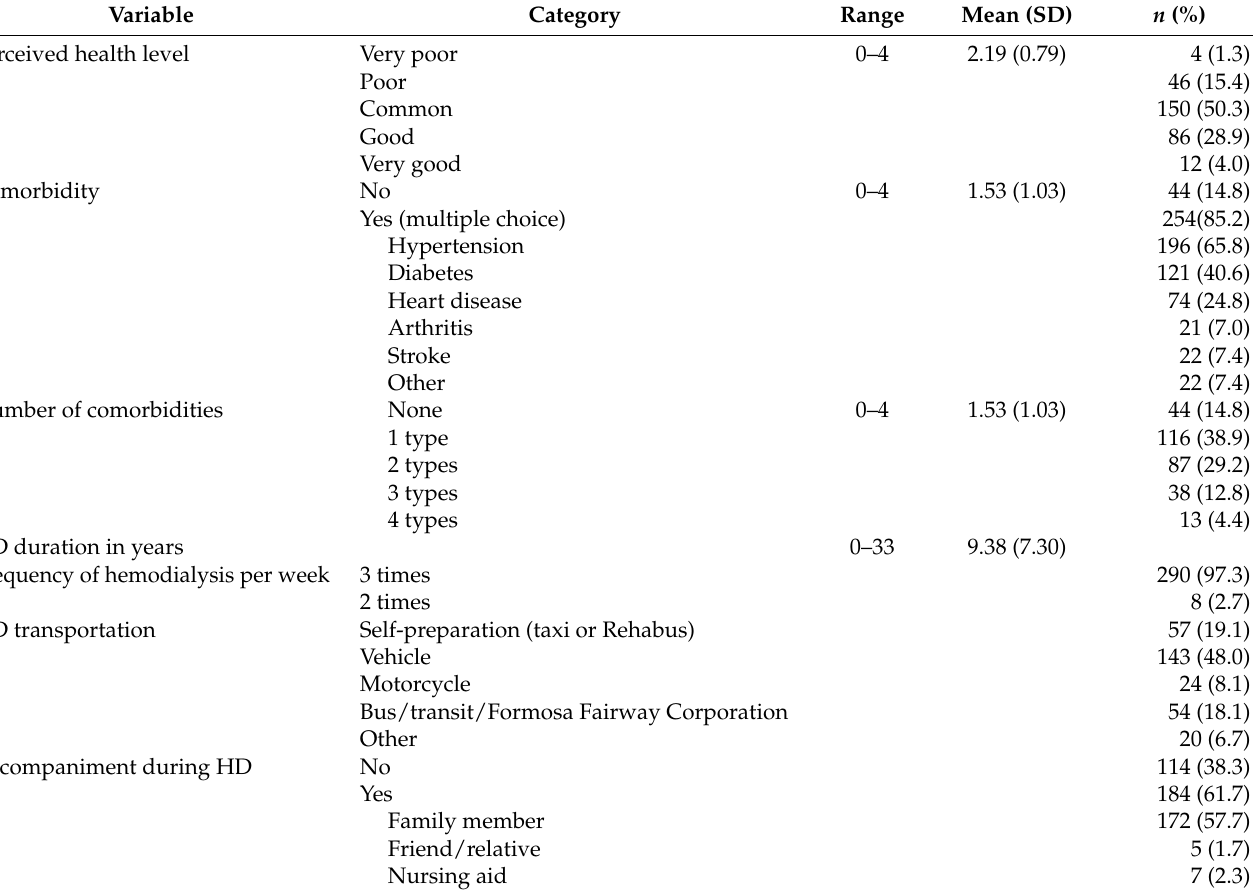
Table 3. Clinical characteristics of hemodialysis patients ( n =